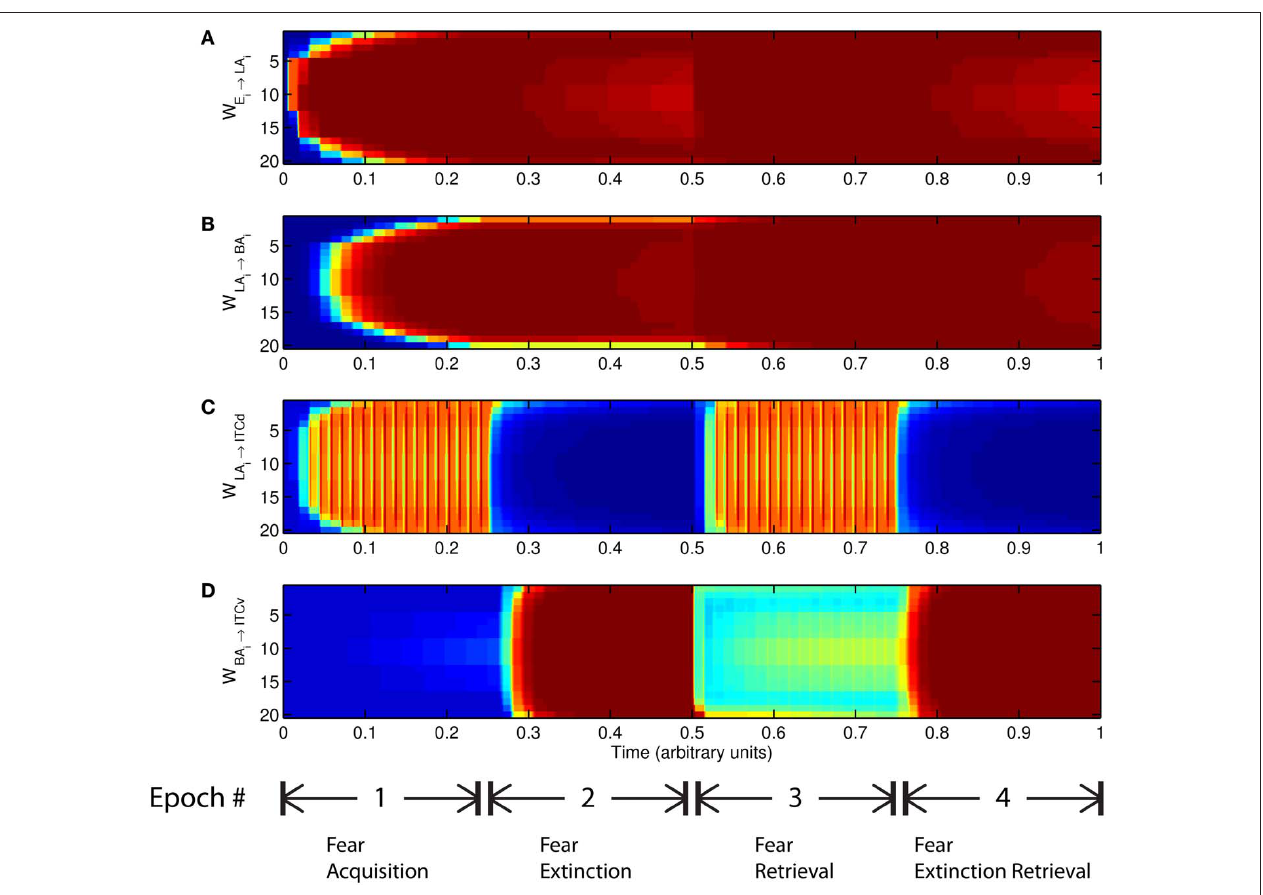
the color representing connection strength (Blue is low, red is high). In the first and third epochs, the CS signals co-occur with R + , the US. In the second and fourth epochs, one of the CS signals is presented without R + . (Parameters: strength of inhibition f I = 0 . 3; input from IL to ITCd E ILd = 0; input from IL to ITCv E ILv =